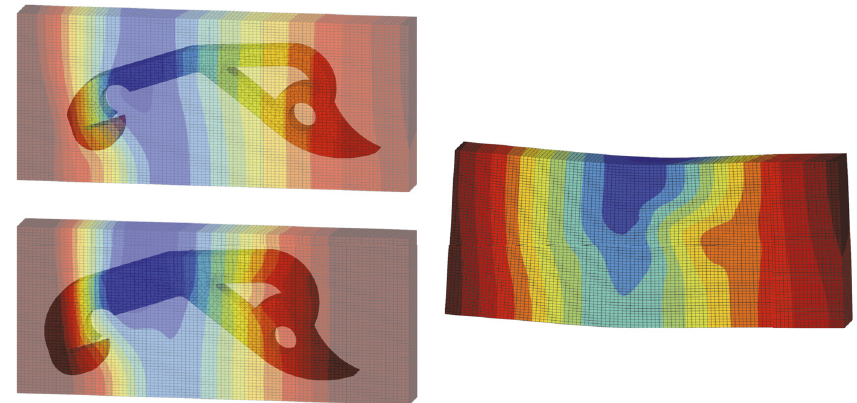
Figure 4: On the left, examples of vertical displacements in the bounding box superposed to the related finite element prediction, for the mesh G 1 on the top and the mesh G 4 on the bottom, with a colour scale related to the displacement magnitudes. On the right, the first feature ̂ 𝑉 [:, 1] mode , for vertical displacements too.